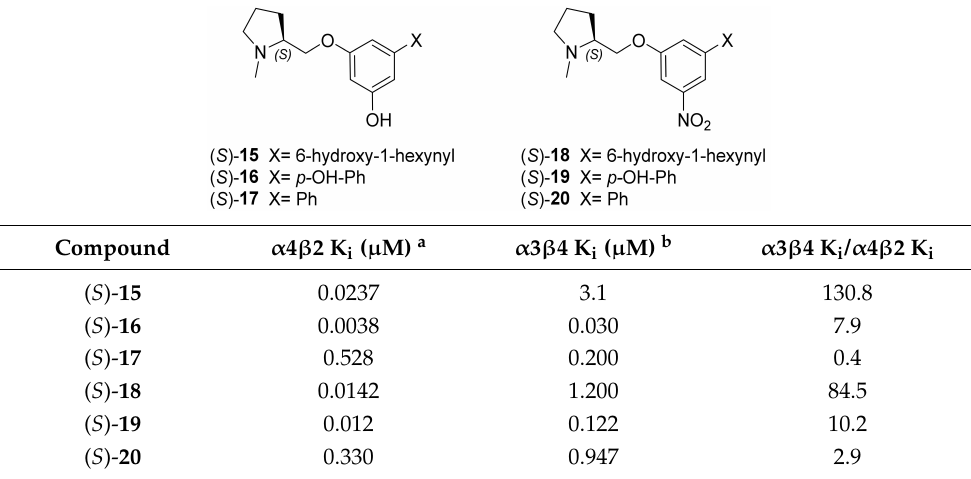
Table 3. Binding affinity data at α 4 β 2 and α 3 β 4 nAChRs and α 4 β 2 vs. α 3 β 4 selectivity ratio of compounds 15 – 20 reported by Bolchi et al. [7]. a Tested at rat cortex using [ 3 H]-epibatidine. b Tested at membranes of human α 3 β 4 transfected cells.